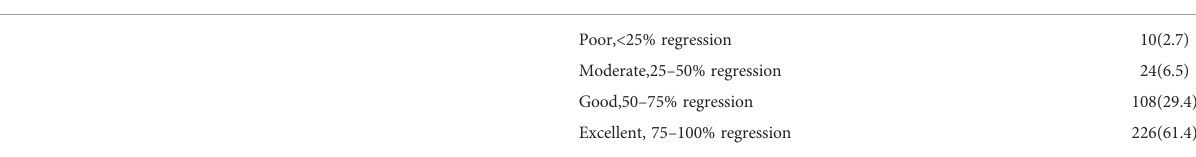
TABLE 3 Clinical response to sclerotherapy in infantile hemangiomas. Achauer et al. as